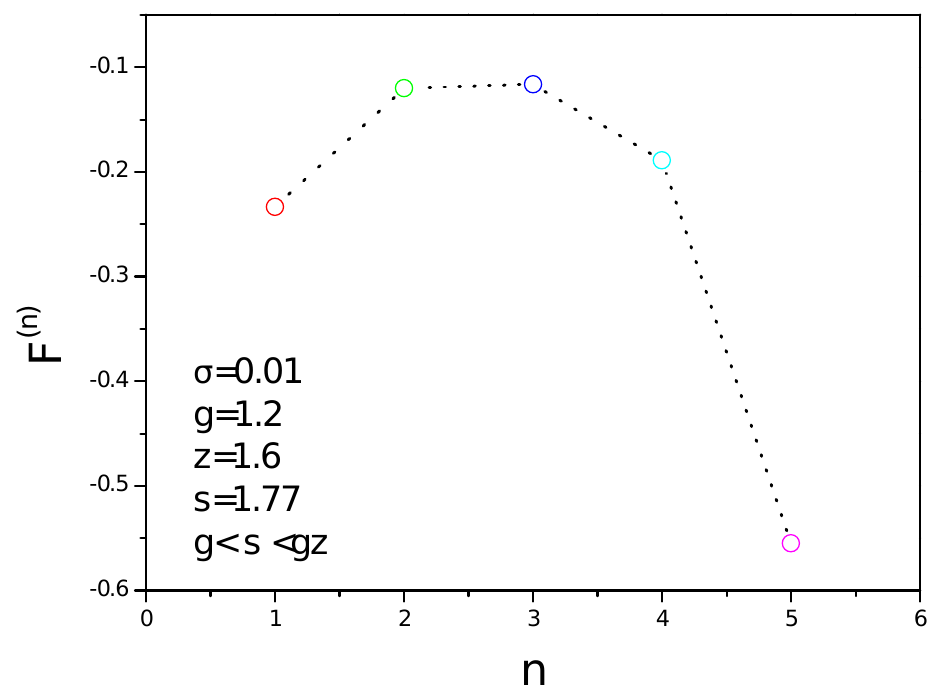
Figure 6. Free energy landscape for different molecules gives a nonmonotonic function that has a peak at three molecules. F ( n ) is the free energy of an oligomer containing n